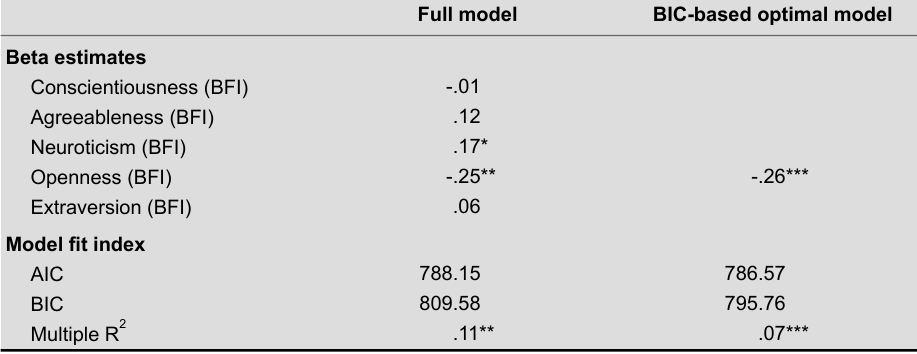
Regression Results for Predicting Centrality of Visual Aesthetic Products - Acumen, Using glmulti to Exhaustively Fit All Possible Models